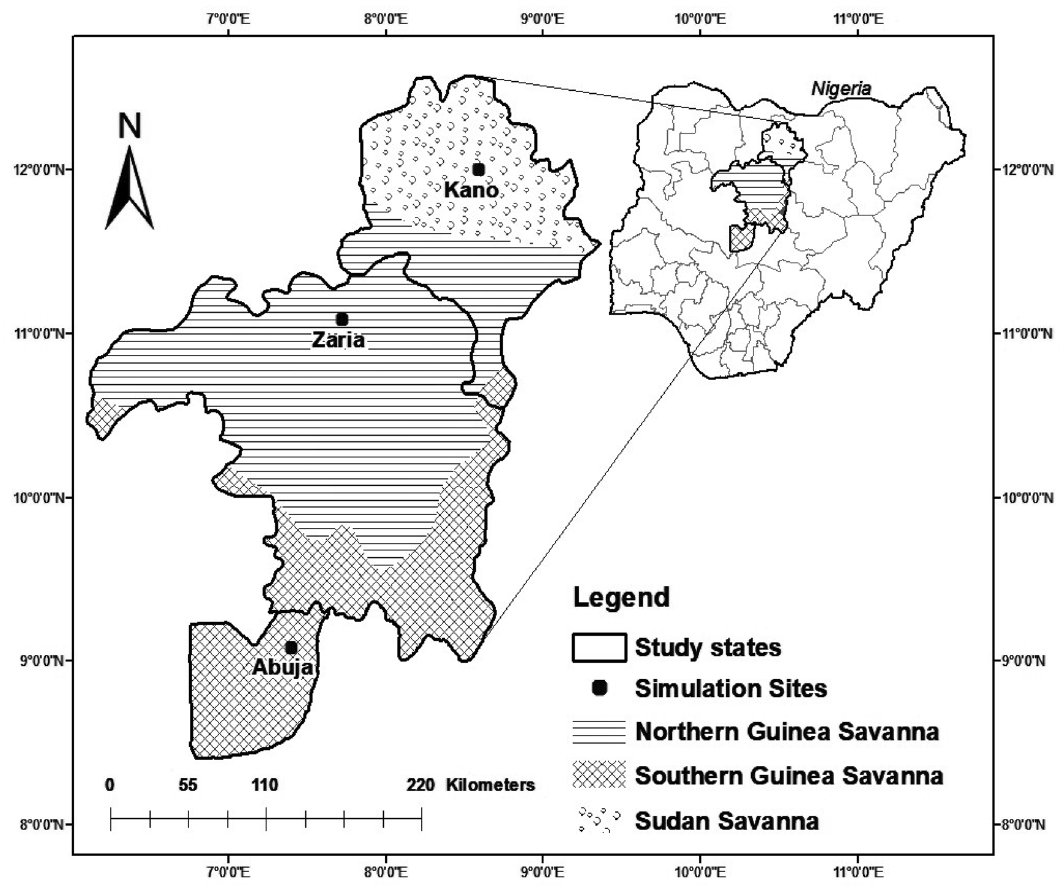
Figure 1. Map of the study area. This map was created using ArcGIS [GIS software] version 10.4.1. Redlands, CA: Environmental Systems Research Institute, Inc., (Copyright ESRI, 2015). ESRI. (2015). Copyright 2015. ArcGIS 10.4.1 Computer software. Redlands, CA: